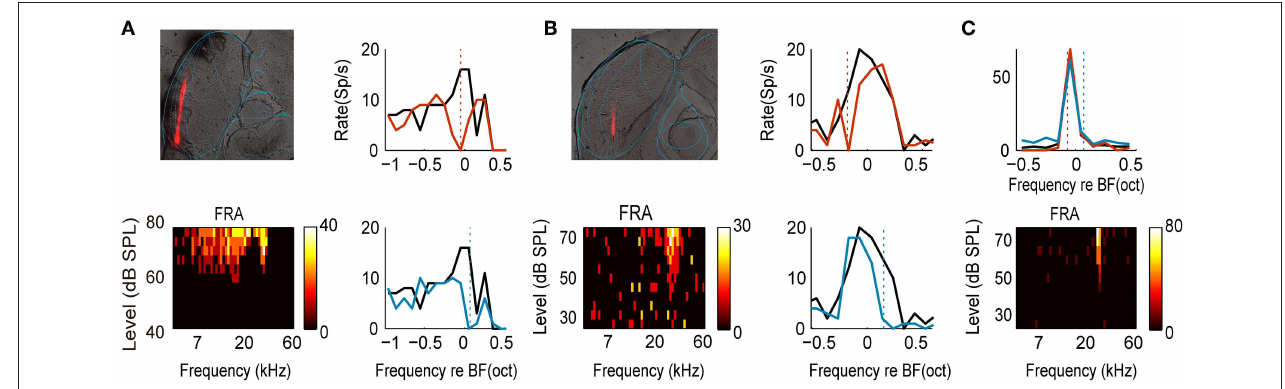
FIGURE 6 | The examples of two recording sites and a non-adapted neuron. (A) An example of recording site in external cortex of IC. Top left: brain section (60um). Red track: DiI red fluorescent mark of electrode track. Blue: rat brain atlas outline (adapted from Paxinos and Watson, 2007). Bottom left: FRA of one example neuron from this site (CF = 17.3kHz, BW 25 = 2.66 octaves). Right: frequency tuning curves measured with uniform (black) and biased ensemble (colored) with two adaptors. The dashed vertical lines indicate the adaptor positions. (B) An example of recording site in central nucleus of IC. Same convention as in (A) . CF = 28.1kHz, BW 30 = 0.70 octave. (C) An example of non-adaptive neuron. Top: frequency tuning curves measured with uniform (black) and biased ensemble (colored) with two adaptors. The dashed vertical lines indicate the adaptor positions for corresponding colored curves. Bottom: FRA of this neuron (CF = 26.6kHz, BW 30 = 0.16